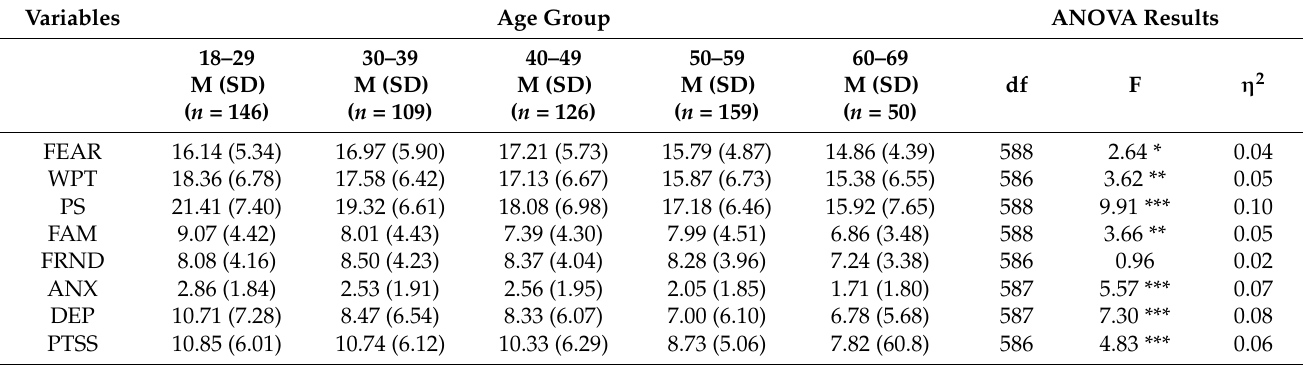
Table 4. One-way Analyses of Variance (ANOVA) in variables of interest by age group ( n = 590). Variables Age Group ANOVA